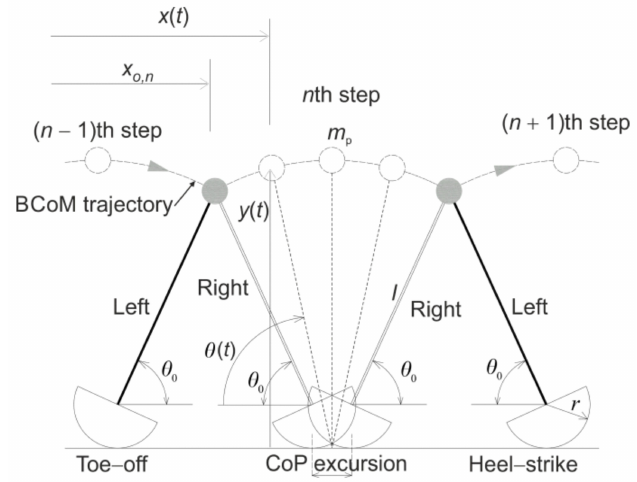
Figure 10. Inverted pendulum with rocker foot